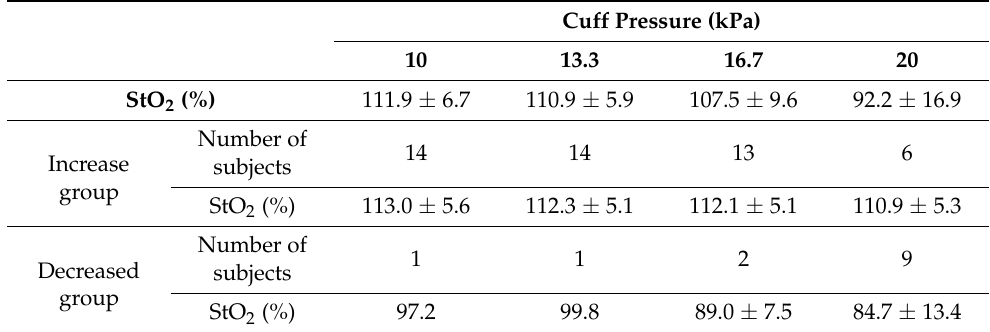
Table 4. Mean ± SD of StO 2 for increased and decreased groups according to cuff pressure.